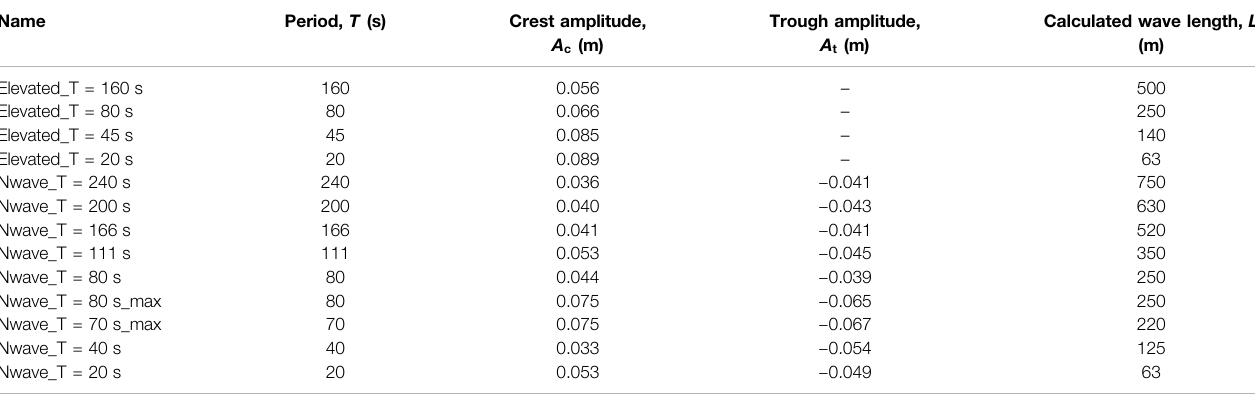
TABLE 1 | Calibrated crest only (elevated) waves and N-waves using second generation